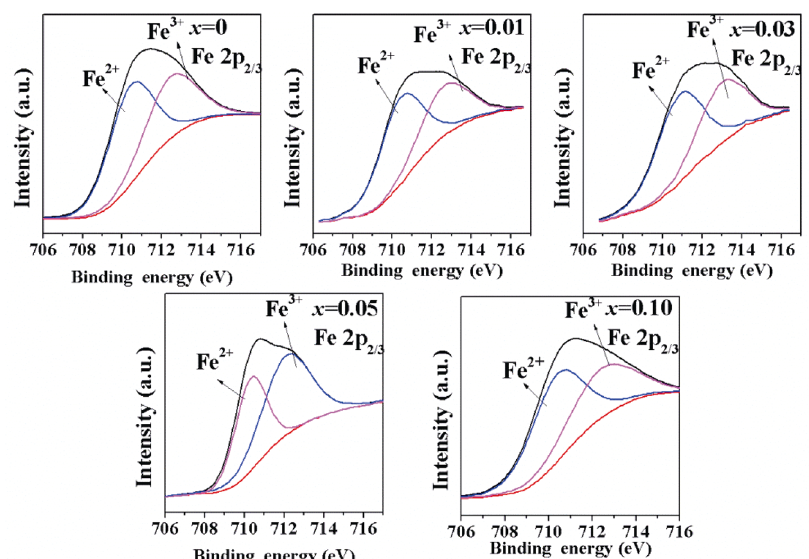
Fig. 4 Fe 2p XPS spectra of the CuFe 1– x Mn x O 2 samples.